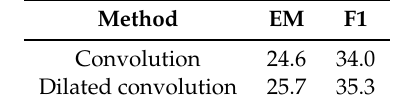
Table 5. The comparison between the convolution and dilated convolution.